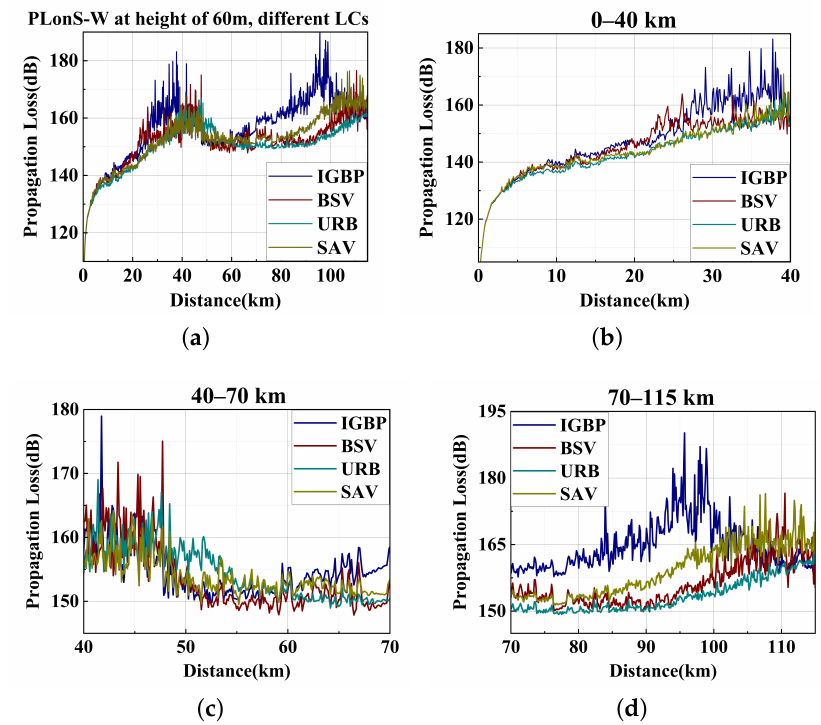
Figure 21. The propagation loss using the improved TWPE at a height of 60 m using different land covers, on Shanghai–Wuxi. ( a ) PL on S–W at different LCs at a antenna height of 60 m. ( b ) PL on S–W at a range of 20–40 km at different LCs. ( c ) PL on S–W at a range of 40–70 km at different LCs. ( d ) PL on S–W at a range of 70–115 km at different